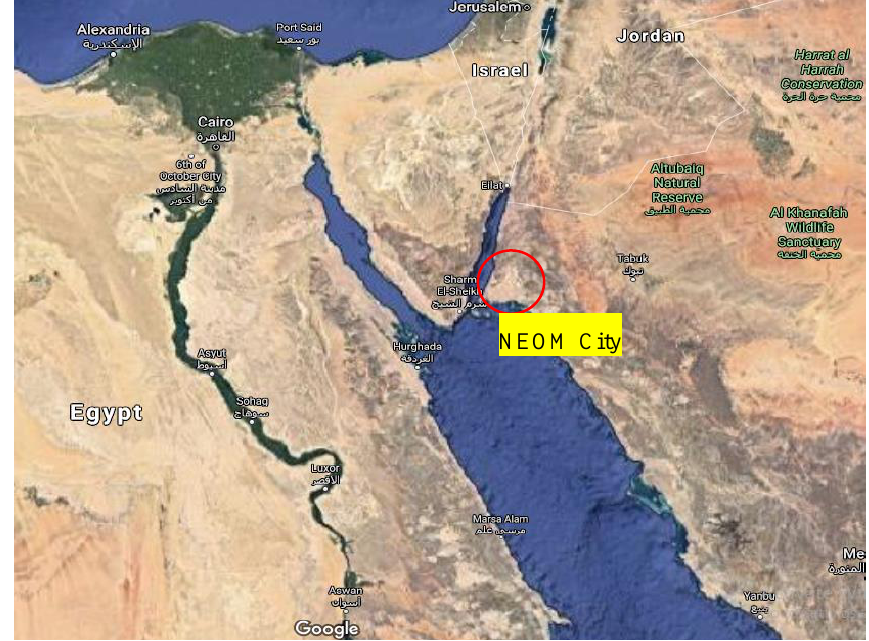
Figure 2. Location of the case study of NEOM City, Saudi Arabia (www.google.com/maps).